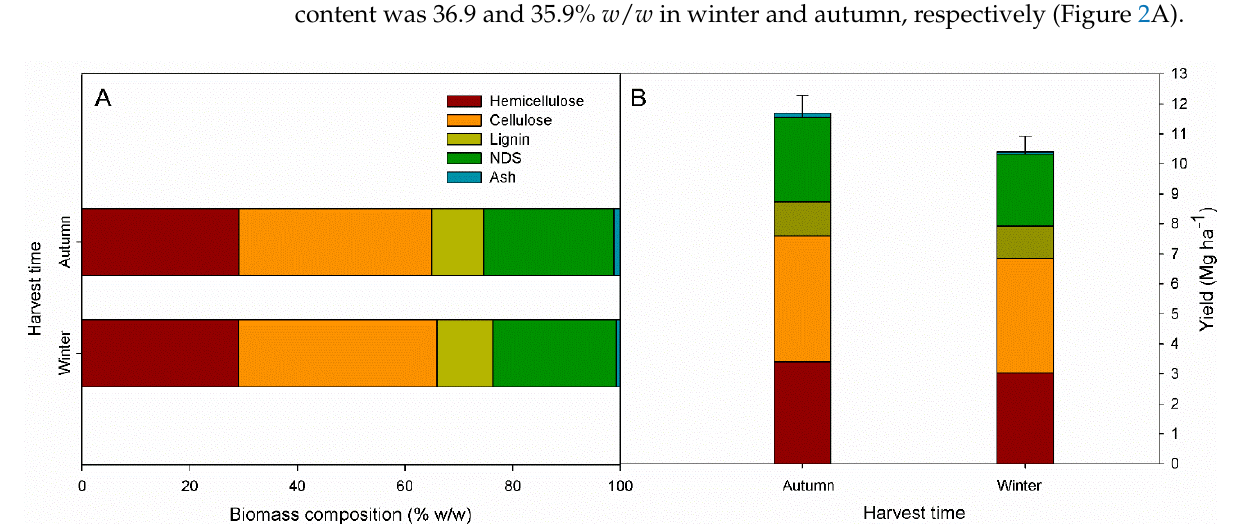
The ADL content was 10.4% w / w in winter and 9.6% w / w in autumn harvest, while ash content was higher in autumn than winter (1.2 and 0.7% w / w , respectively). Although not significant, hemicellulose and NDS content were higher in autumn (29.1 and 24.2% w / w , respectively) than winter (29.0 and 23.9% w / w , respectively), while the cellulose content was 36.9 and 35.9% w / w in winter and autumn, respectively (Figure 2A).